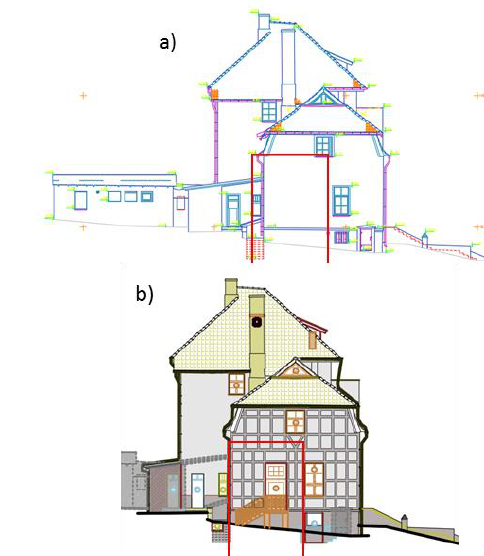
Table 1. Results of deviations Elements